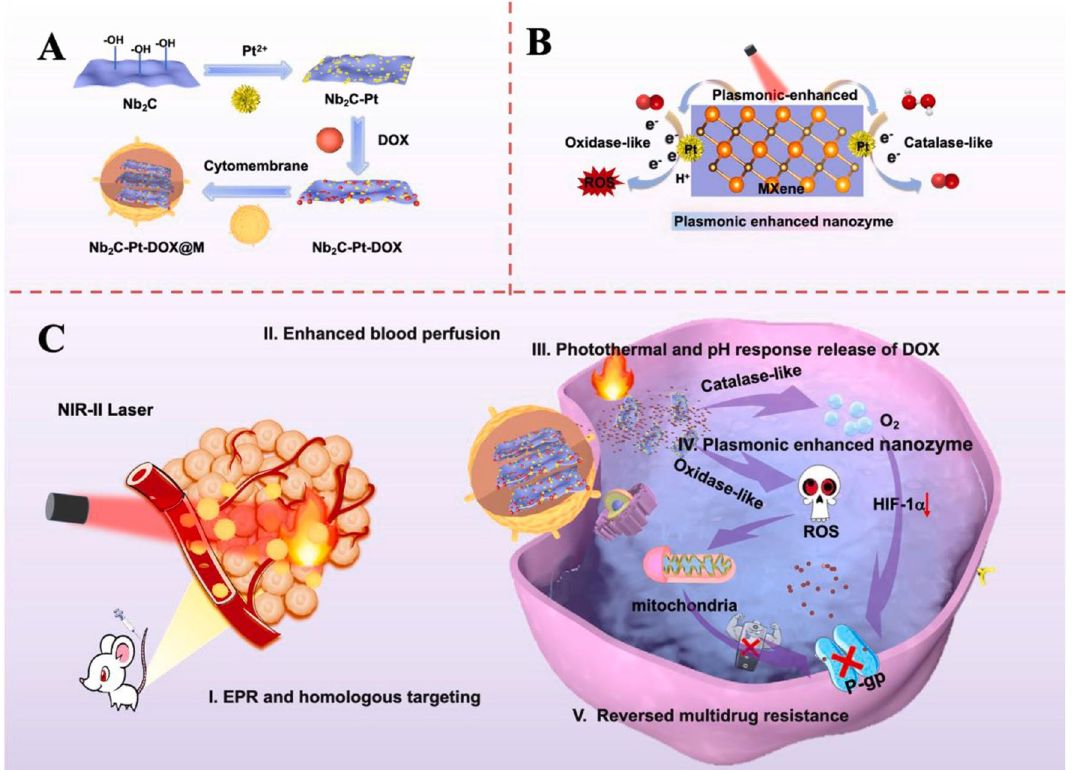
Fig. 1 A The preparative process for biomimetic photo-induced plasmonic assembly for targeted cancer nanotherapy in NIR-II bio-window (in vivo). B The catalase- and oxidase-like performance of Pt nanozyme, and C related mechanism of drug release and tumor suppression ( I – V ). M MXene, DOX doxorubicin. Reproduced with permission from Ref. [70]. Copyright 2021